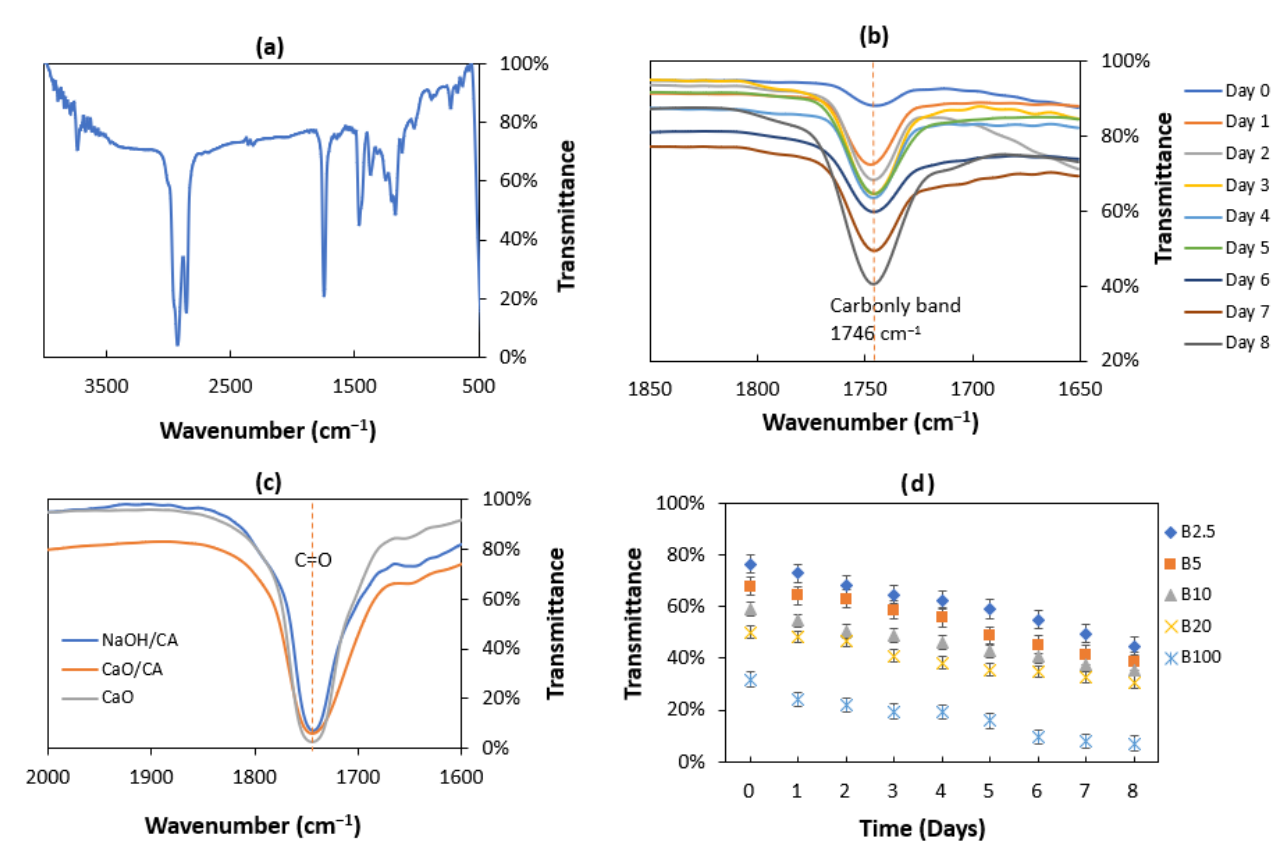
Figure 11. Changes in FTIR spectra of biodiesel and biodiesel/diesel blends under accelerated oxidation. ( a ) Fresh BSFL biodiesel, ( b ) B2.5 spectra, ( c ) comparison spectra of B100 on Day 8 for different catalysts and ( d ) transmittance strength at 1746 cm − 1 of biodiesel and blends .